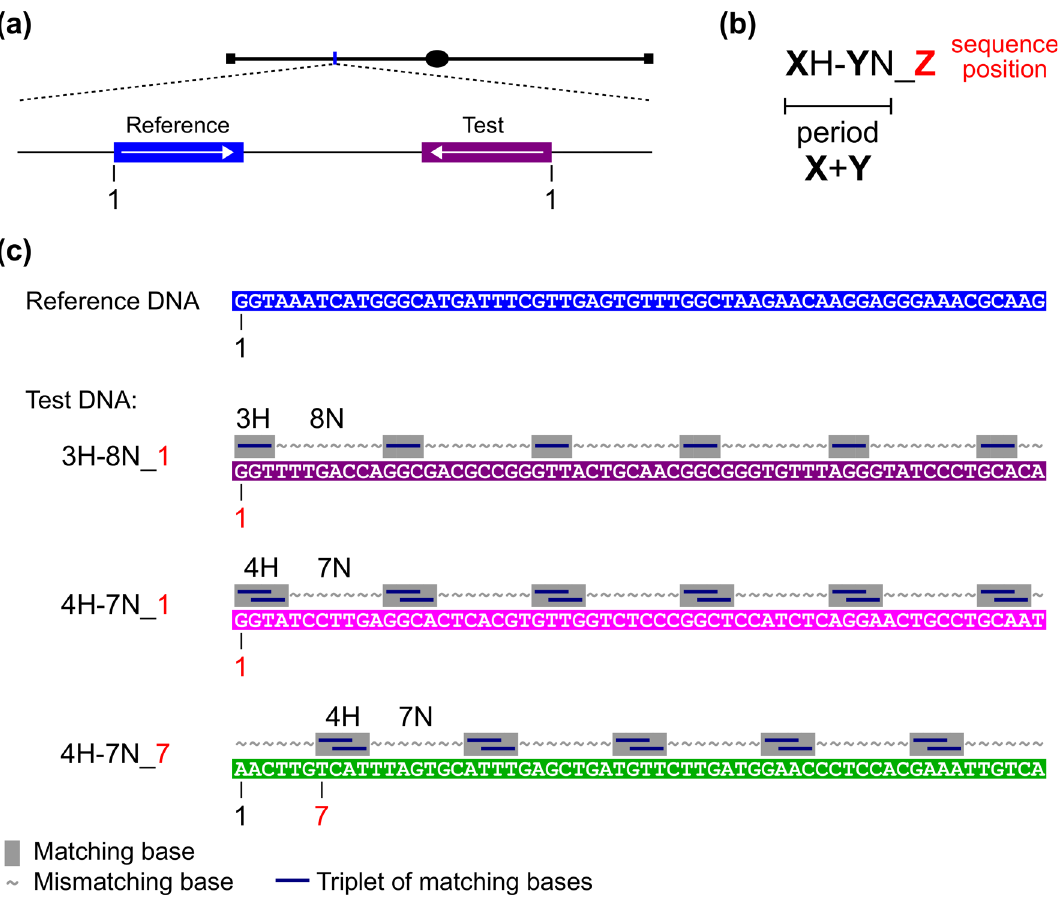
Fig 1. A sensitive genetic system for assaying RIP in regions of interspersed homology. (a) Tester constructs comprise pairs of closely-positioned DNA repeats: the base-pair sequence of the “ left ” repeat ( “ Reference ” ) is held constant and corresponds to an arbitrarily chosen segment of the Neurospora genome, the base-pair sequence of the “ right ” repeat ( “ Test ” ) can be varied as desired. (b) Patterns of interspersed homology (relative to the reference sequence) are defined by the three distances: X — the length of the homologous unit, Y — the separation between homologous units, and Z — the sequence position of the first homologous unit relative to the reference sequence. The sum of X and Y defines the periodicity of interspersed homology. (c) Alignment of a reference sequence and three different test sequences. A minimally effective pattern of interspersed homology is "3H-8N" [14]. One such pattern, with the sequence position parameter set to 1 ( Z = 1), is shown as 3H-8N_1. Two homology patterns examined in this study are 4H-7N_1 and